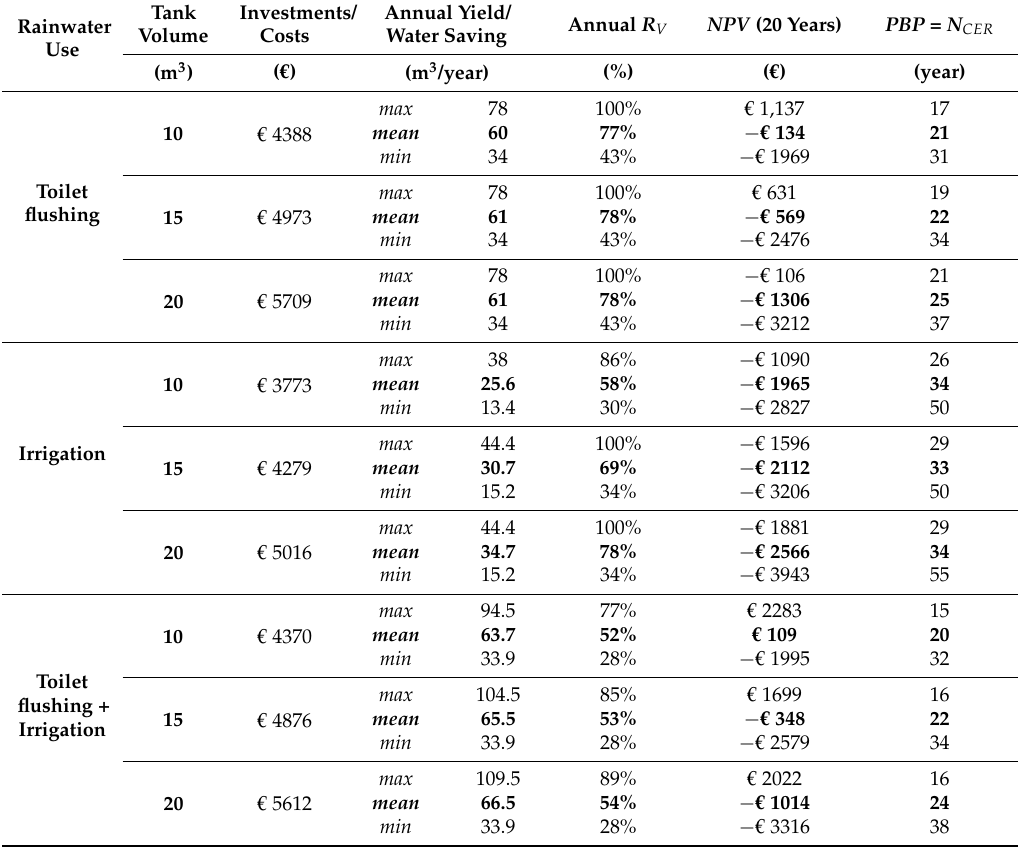
Table 5. NPV and PBP values related to each tank size and different annual yields for each rainwater